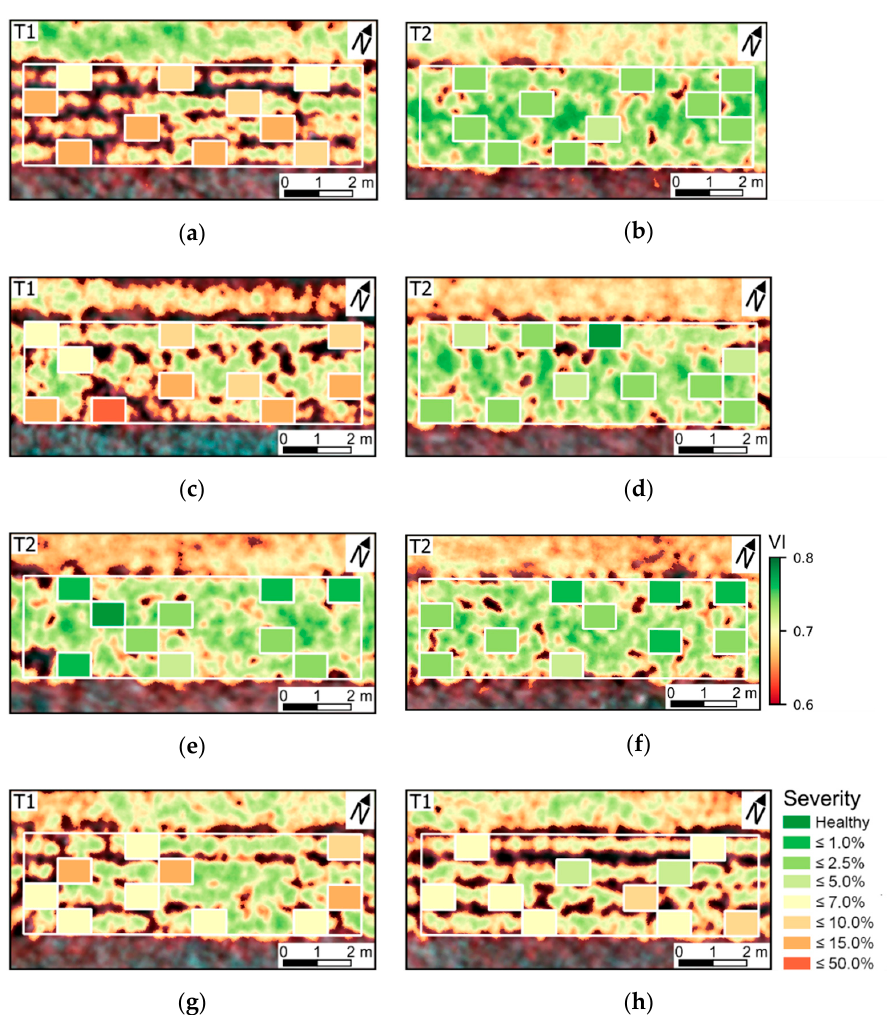
Figure 9. Distribution of visual scores into specific classes of late blight severity (according to the approximate percentage of affected leaf area) in SUs evaluated 78 DAP. Experimental plots 1–8 are indicated by figures ( a – h ). Background images include values of OSAVI (Optimized Soil Adjusted Vegetation Index; VI) for pixels retained after vegetation segmentation and a false color composite (833, 663, and 609 nm as RGB